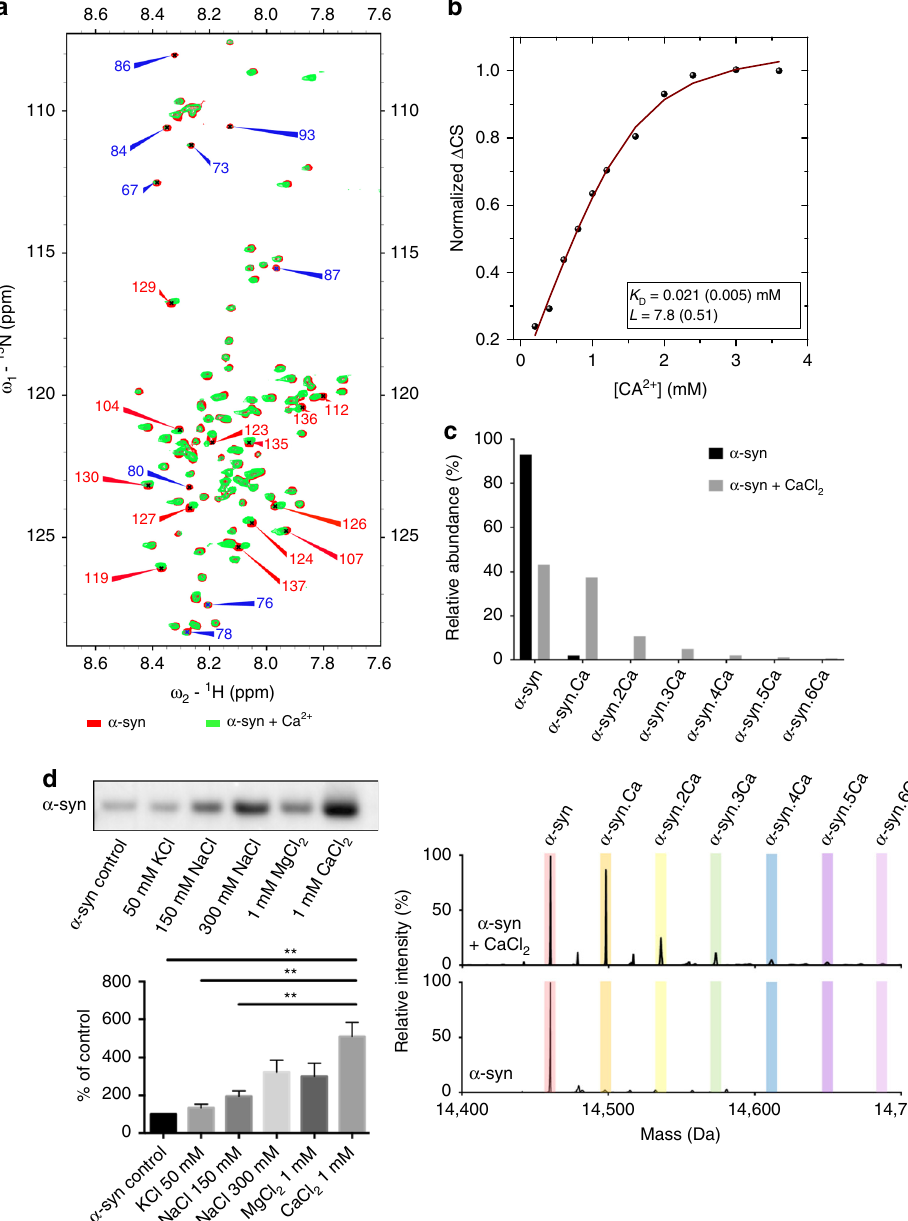
Fig. 1 Calcium binding to the C terminus of alpha-synuclein and lipid binding. a 1 H- 15 N HSQC NMR spectrum of alpha-synuclein in the absence (red) and in the presence of calcium (green, 1.6 mM calcium). Major chemical shift perturbations in the presence of calcium are located at the C terminus of alpha- synuclein (red arrows with assigned amino acid residues), whereas peak broadening (blue arrows with assigned amino acid residues) can be seen within the NAC-region. b Fitting of alpha-synuclein calcium binding ( K D ) from 1 H- 15 N HSQC NMR spectra at increasing calcium concentrations, where L indicates the number of Ca 2 + ions interacting with one alpha-synuclein molecule. c Calcium-bound alpha-synuclein species directly observed by mass spectrometry. Electrospray ionization mass spectra were acquired under identical instrument conditions for samples incubated with or without calcium. Multiple alpha- synuclein species were observed upon charge deconvolution of the ion envelope for the 9 + – 19 + charge states, inclusive. The masses correspond to alpha- synuclein: calcium complexes up to a stoichiometry of 1:6. d Lipid pull-down experiment using lipids from Folch brain extracts, recombinant alpha-synuclein and various ions. Western blot of the amount of protein pulled down shows that more alpha-synuclein was pulled down by the lipids in the presence of calcium. Neither potassium, sodium, nor magnesium increased alpha-synuclein lipid binding to the same extent. ** p = 0.0011, 0.0022, and 0.0090 for comparison of 1 mM CaCl 2 with alpha-syn control, 50 mM KCl, and 150 mM NaCl, respectively. Calculated using one-way ANOVA with Tukey ’ s post-hoc correction, graphs indicate mean ± s.e.m. N = 3 for all groups, corresponding to three biological repeats, d.f.